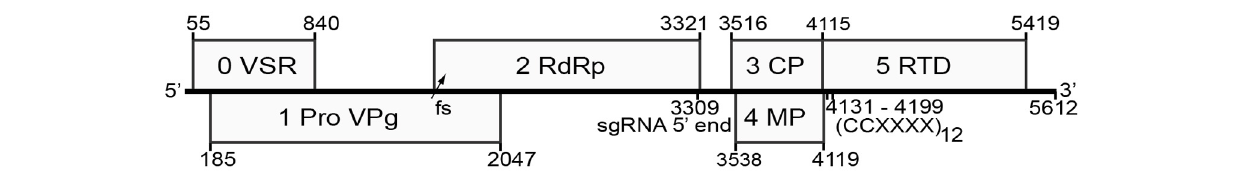
FIGURE 1 | Genome organization of BYDV-RMV. Numbers in small font indicate genomic positions of each ORF (numbered in